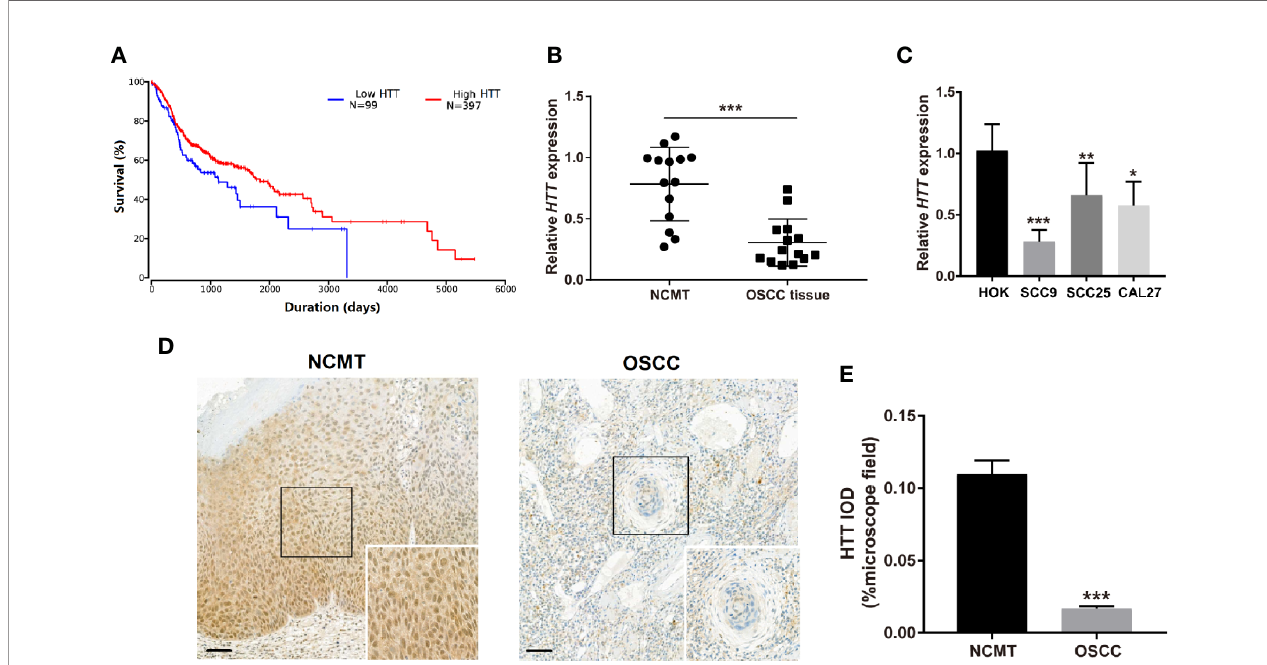
FIGURE 4 | HTT expression pattern in OSCC correlated with survival rate and duration. (A) Kaplan-Meier survival curves for 397 OSCC patients with high HTT expression and 99 OSCC patients with low HTT expression. (B) HTT mRNA expression pattern in OSCC tissue and non-cancerous matched tissue (n = 14). (C) HTT mRNA expression pattern in HOK cells and OSCC cell lines (n = 3). (D) Representative images of immunohistochemistry sections showing HTT protein expression in OSCC tissue and non-cancerous matched tissue. (E) Quantitative analysis of HTT protein expression in immunohistochemistry sections (n = 14). Data are presented as mean ± SD. Signi fi cant difference, *P < 0.05, **P < 0.01, and ***P < 0.001. Scale bar, 100 m